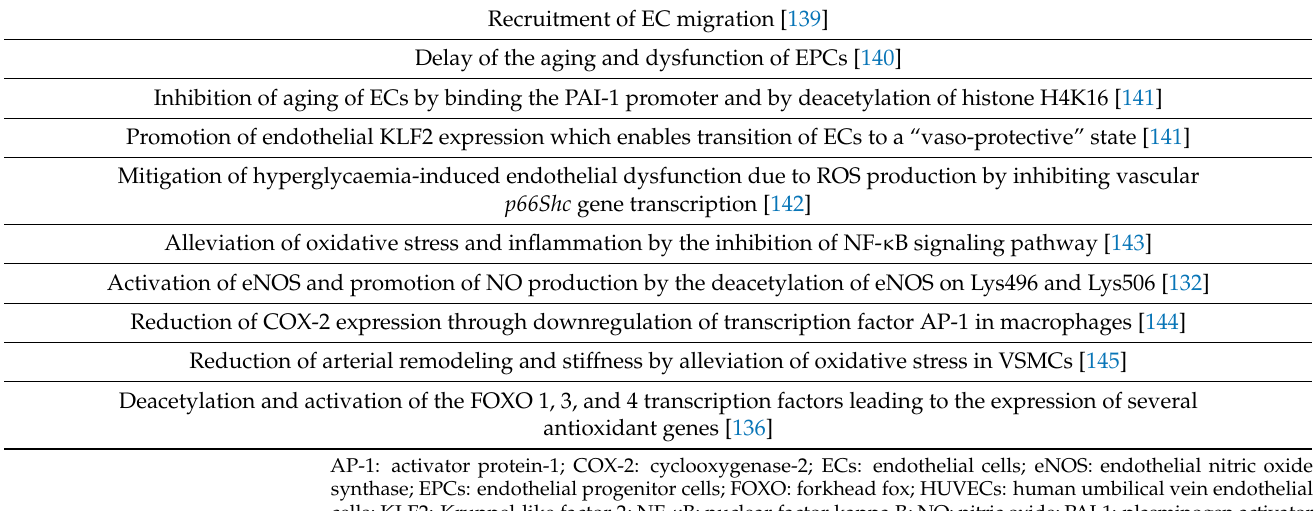
p66Shc gene transcription [142]